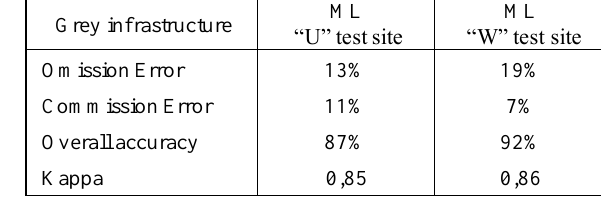
Table 4. Maximum Likelihood classification of grey infrastructure accuracies.